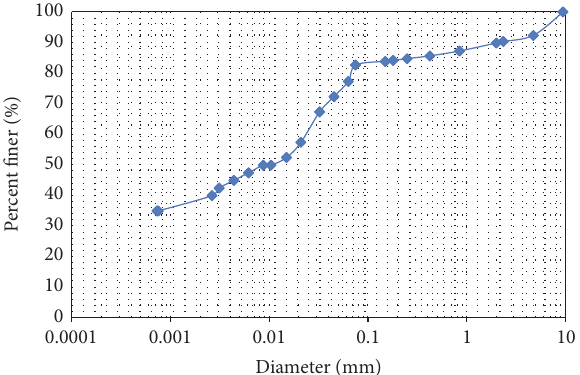
Figure 1: Grain size distribution of the soil.